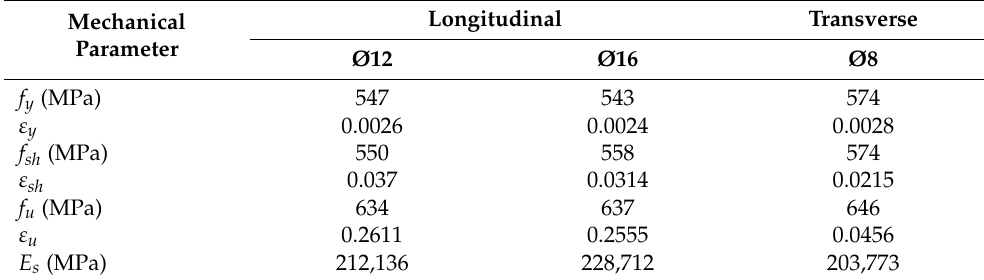
Table 4. Steel reinforcement mechanical properties.